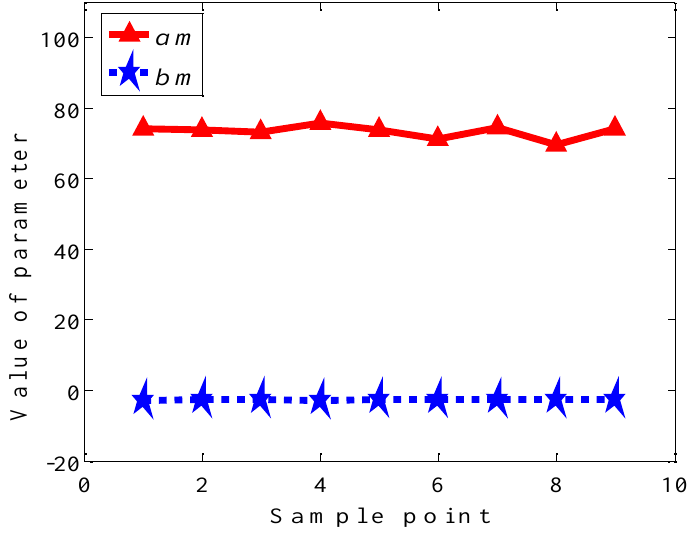
Figure 5. Values of parameter am and bm